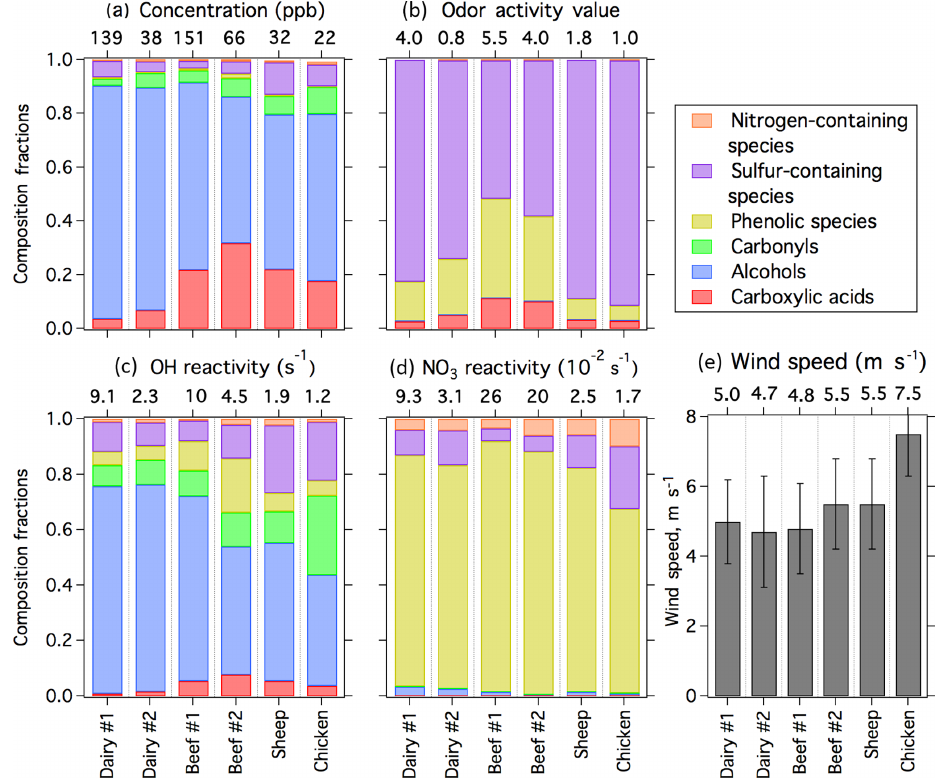
Figure 3. The fractional contributions of different VOC classes to the total VOC concentrations (a) , odor activity values (b) , OH reactivity (c) and NO 3 reactivity (d) for the six investigated CAFO sites. The mean wind speeds during the measurements of the CAFO sites are shown in panel (e) . The mean values for the five parameters from each CAFO are shown at the top of each